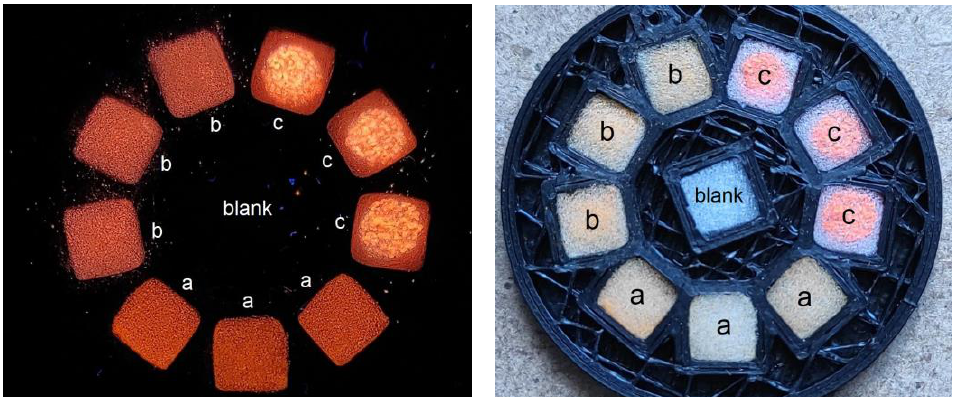
Figure 8. Sensor element cartridge under UV (left) and visible (right) illumination fitted with the foam substrate fragments bearing fluorescent materials mF/Elsp (a), mF+PS/Elsp (b), and mF+PS (c).